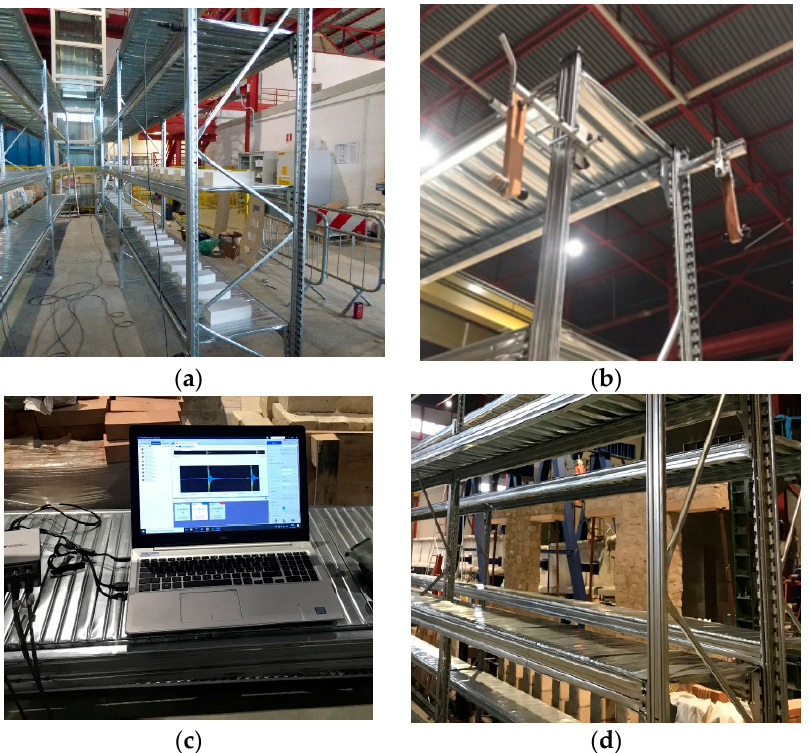
Figure 7. Experimental setup: ( a ) down-aisle view, ( b ) impact hammers, ( c ) data acquisition board, ( d ) cross-aisle view.